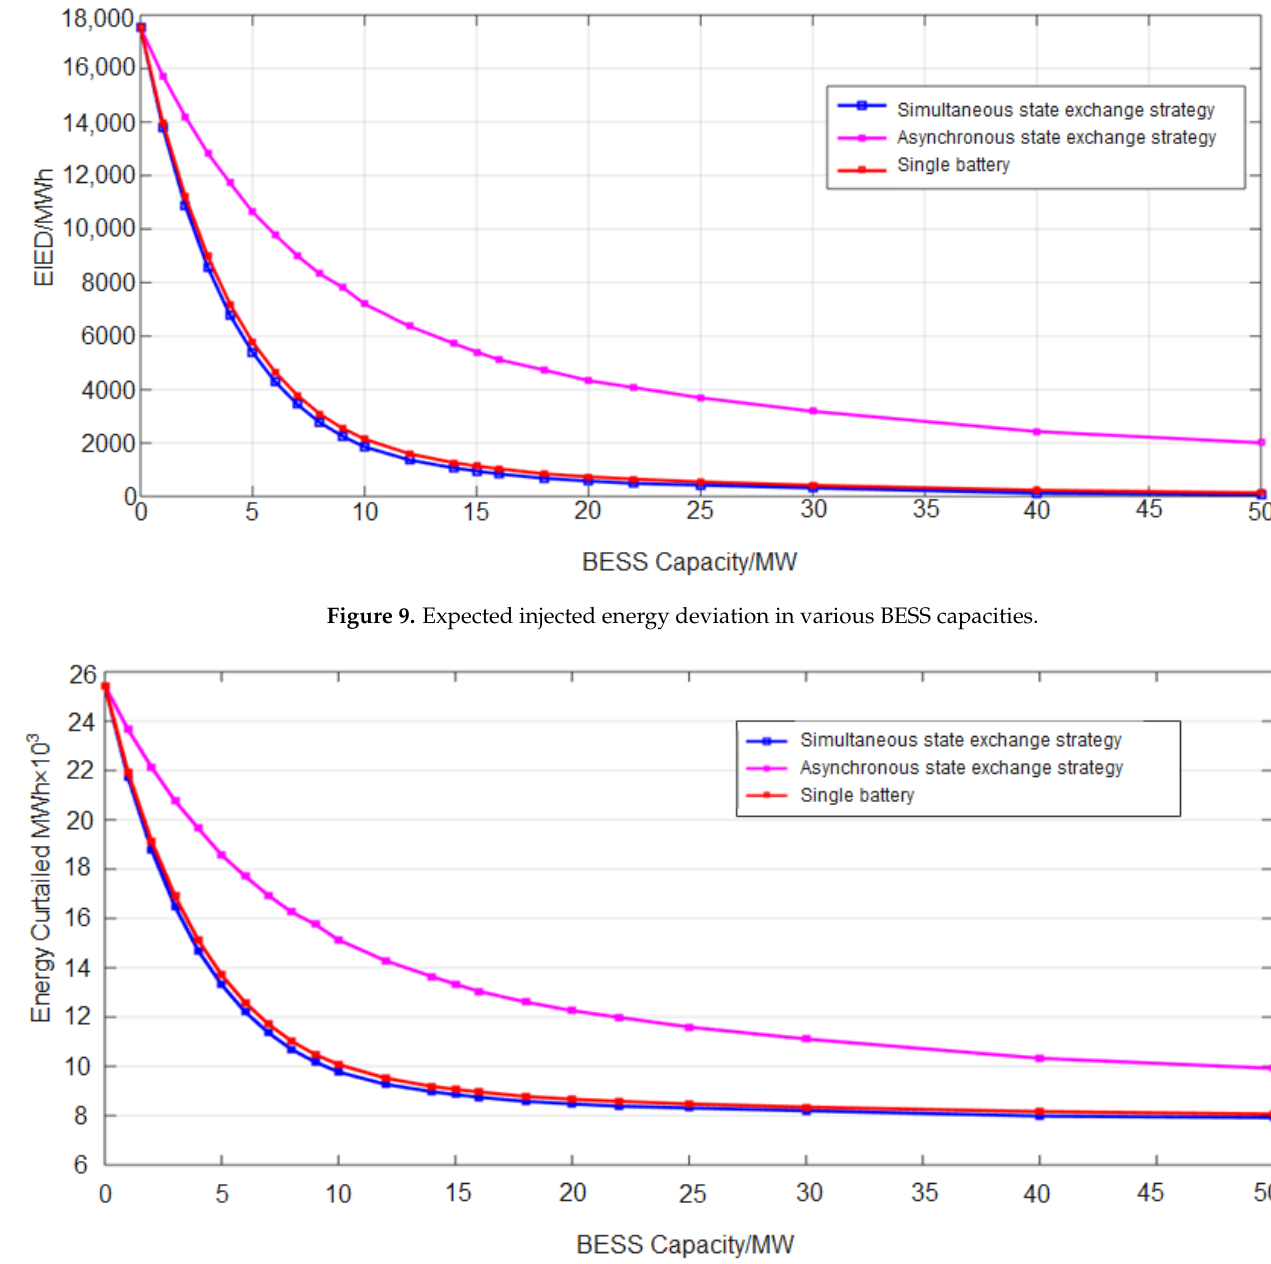
Figure 10. Energy curtailed with various BESS capacities.